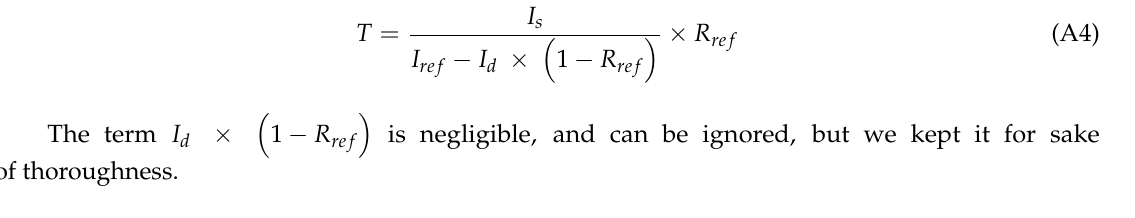
Table B2. Mean p -values in Welch’s t -test comparing differences in mean spectra between measurement methods. The value for each wavelength region (VIS, NIR, SWIR) is the mean of individual p -values of all 1 nm bands belonging to the region. Statistically significant regions ( p < 0.05) are highlighted. R = reflectance, T = transmittance, AD = adaxial side, AB = abaxial side. DIS vs. SIS